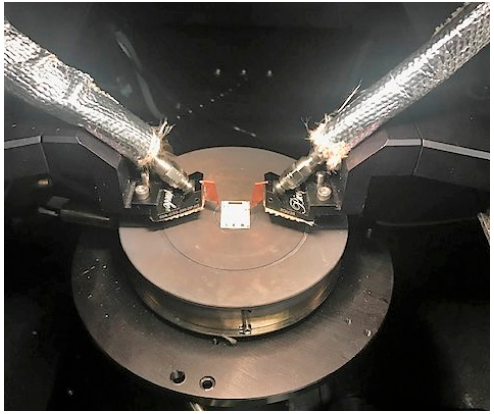
Figure 3. Photograph of the high-temperature measurement setup.